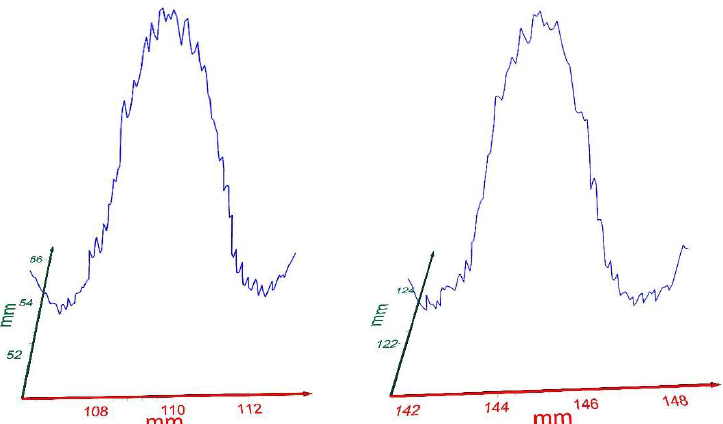
Figure 8. Scanned profile map created from profiles along a line on a row of dies for the entire wafer. This profile map is used for comparing the entire wafer with respect to a known good wafer.